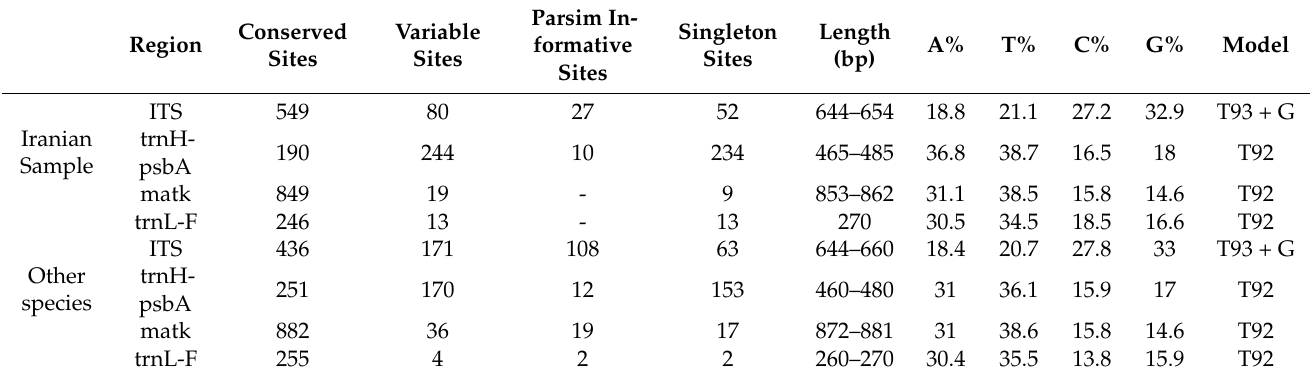
Table 1. Sequences characterization and nucleotide composition four regions trnH-psbA, trnL-F, matK and ITS without the outgroups.